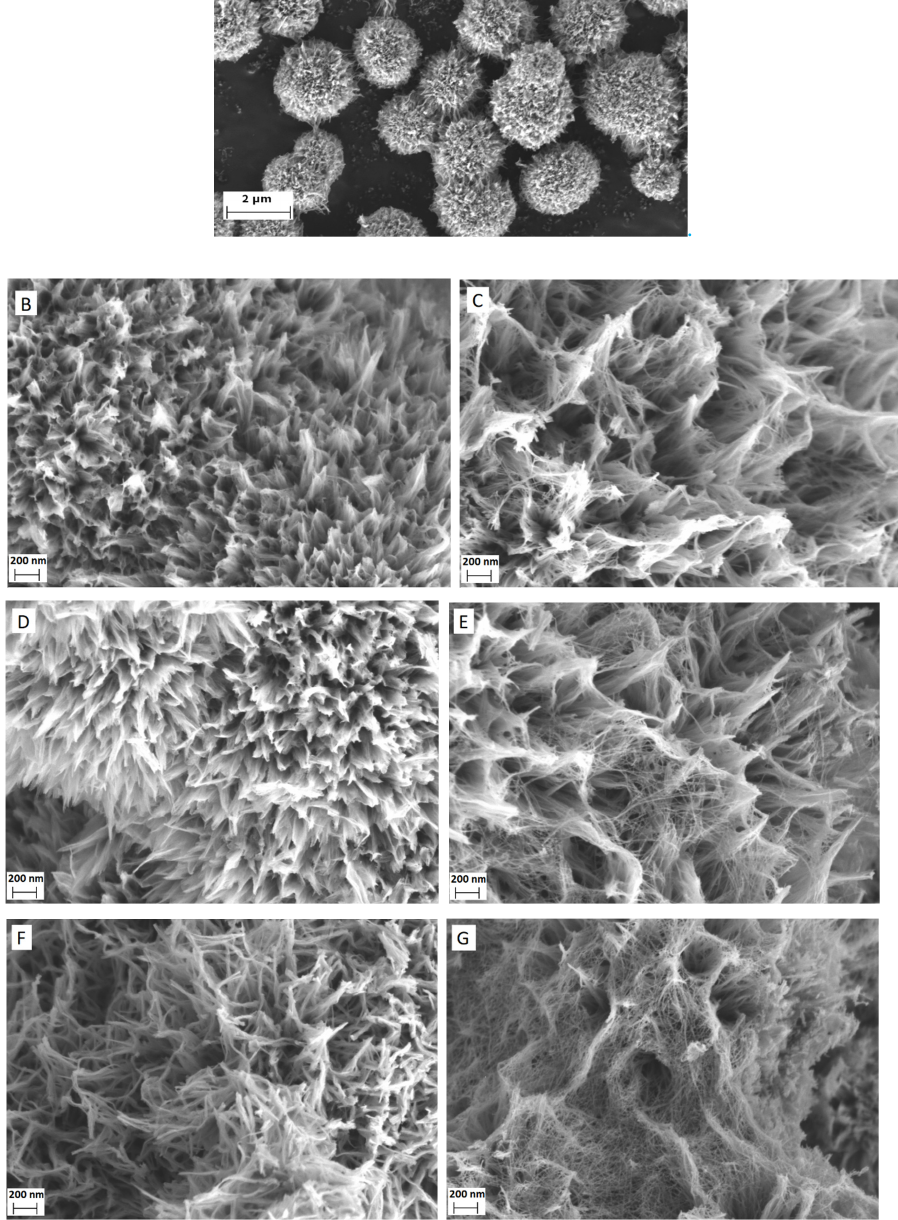
Figure 2. SEM images of samples prepared with different parameters of hydrothermal synthesis and calcinated at 500 °C. The designations ( A – G ) on the images correspond to sample names in section 3.1. Synthesis .